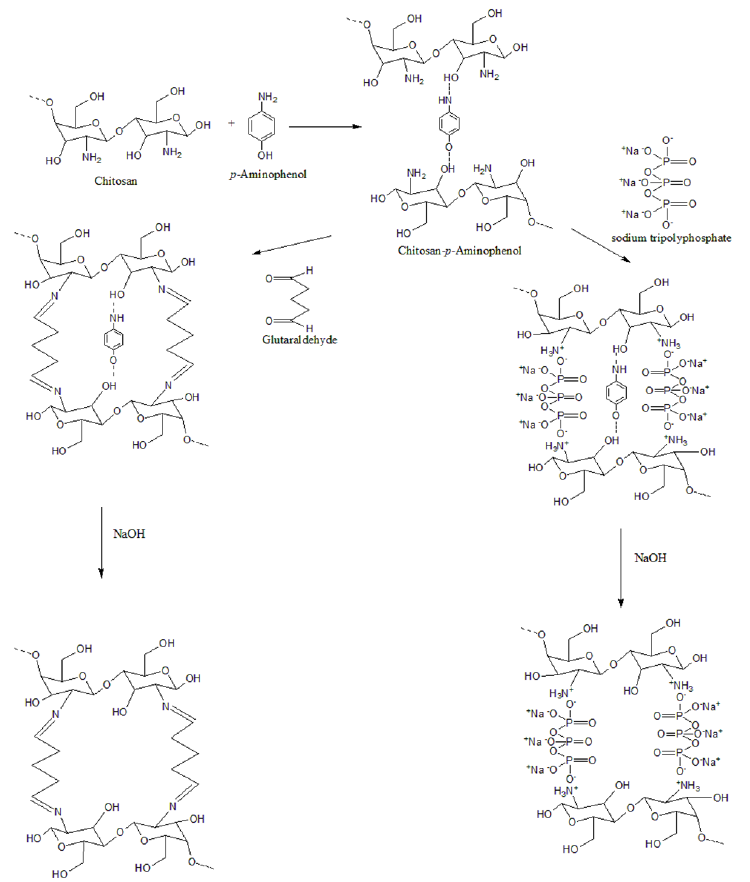
Figure 6. Illustration of the formation of chitosan-based MIPs by glutaraldehyde and STPP as crosslinkers [44].